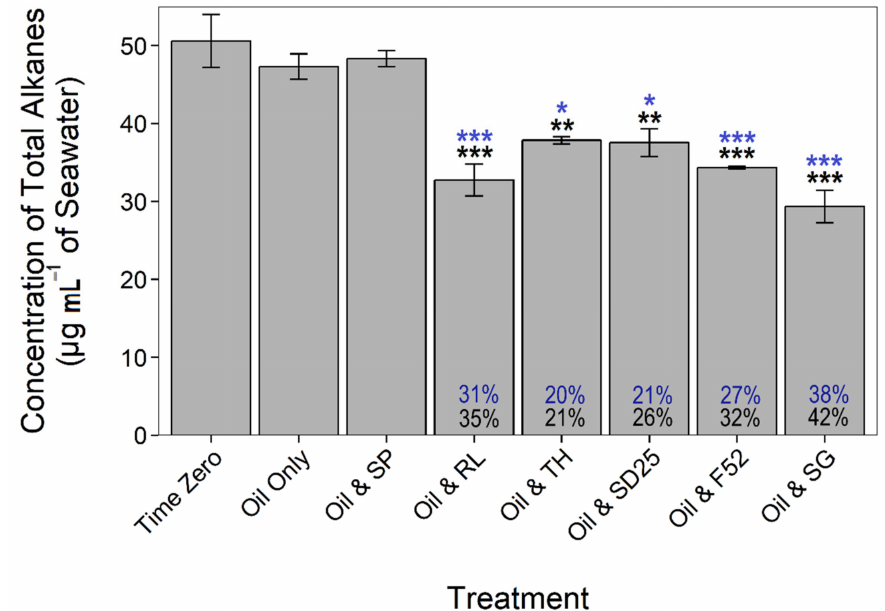
Figure 1. Total alkane concentrations (mean ± SE, n = 2) at day 1. Blue (upper) percentages (and asterisks) represent degradation in comparison to the oil-only control. Black (lower) percentages (and asterisks) represent degradation in comparison to starting concentration (“Time Zero”). Dispersant and biosurfactant codes are as follows: SP = sophorolipid, RL = rhamnolipid, TH = trehalolipid, SD25 = Superdispersant 25, F52 = Finasol OSR 52, and SG = Slickgone NS. *** p < 0.001, ** p < 0.01, and * p <